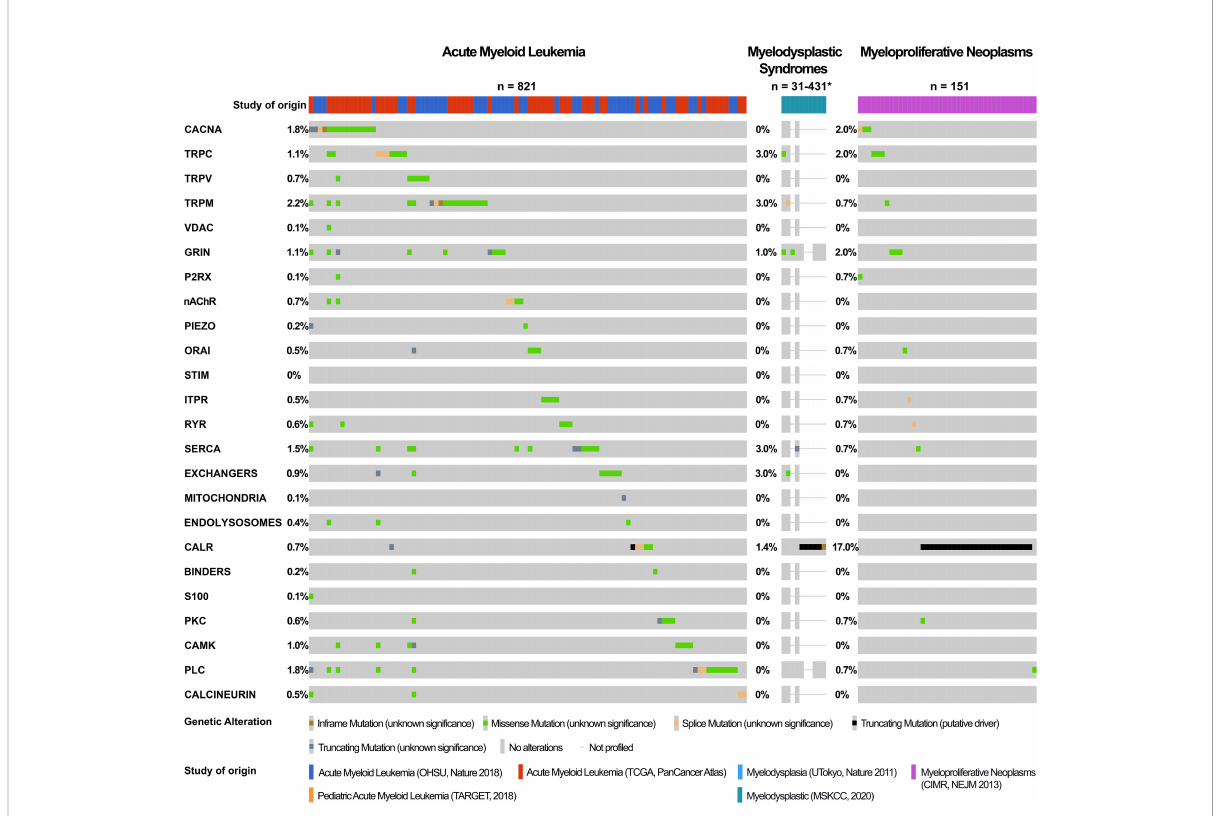
FIGURE 7 Calcium-toolkit mutations in myeloid neoplasms. Oncoprints are shown generated using cBioportal for Cancer Genomics platform (https:// www.cbioportal.org/). Events were analyzed per patient, frequencies are listed. Unaltered columns and whitespaces between columns are not shown. The Ca 2+ -toolkit genes were grouped according to function (see Supplemental Table 1). The molecular pro fi les queried included mutations but excluded copy number variations and structural variants as these were not available for most patients. The databases analyzed are indicated in the fi gure and referenced below: 1) Acute Myeloid Leukemia databases OHSU Nature 2018 (349); TCGA PanCancer Atlas (332 – 340), and Pediatric Acute Myeloid Leukemia TARGET 2018. TARGET data was generated by the Therapeutically Applicable Research to Generate Effective Treatments initiative and is available at https://portal.gdc.cancer.gov/projects. 2) Myelodysplasia databases UTokyo Nature 2011 (350)), MSKCC 2020 (349, 351, 352). 466 MDS patients were excluded from the analysis as they were not pro fi led for any queried genes.